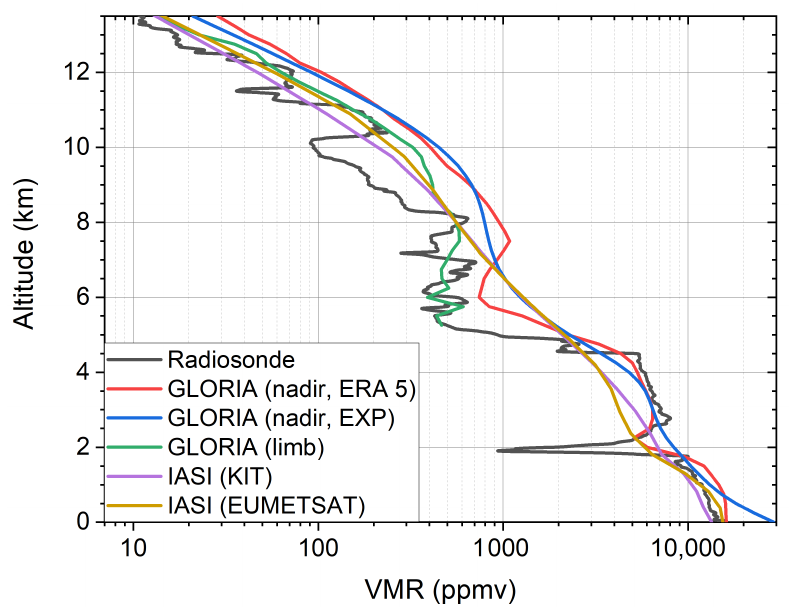
Figure 8. Various mean water vapour profiles in vicinity of the southern flight leg (see Figure 7a,b). The red and blue lines illustrate the mean profiles for the GLORIA nadir retrieval with the ERA 5 and the exponential a priori, respectively. The green line shows the mean profile for the GLORIA limb retrieval. The purple and ochre-coloured lines depict the IASI retrieval mean profiles from KIT and EUMETSAT, respectively. In addition, a radiosonde ascent of the Graciosa station on the Azores is shown in black.